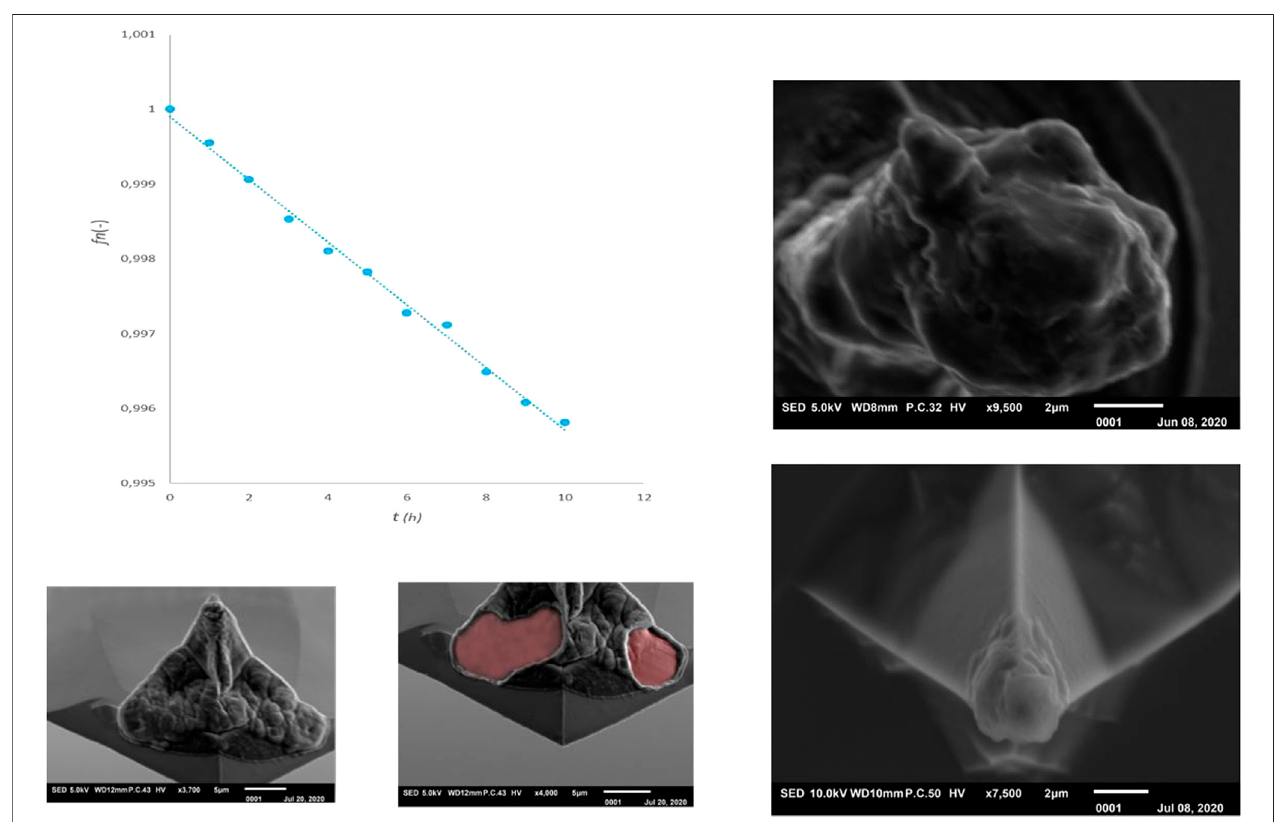
FIGURE 9 | Lithiation of the tip by the dry-alloying (right) and the dry-plating method.